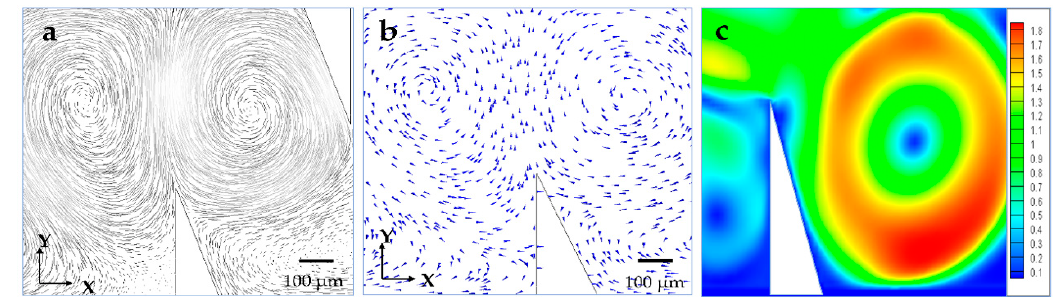
Figure 2. Simulation results of the velocity vector field in the microfluidic chip using FLUENT: the arrow represents the direction of motion of ( a ) the acoustic microstreaming around the oscillating microstructure and ( b ) the flow direction of microstreaming from the X–Y plane of the oscillating microstructure; ( c ) simulation results of the velocity fields, unit: m/s.